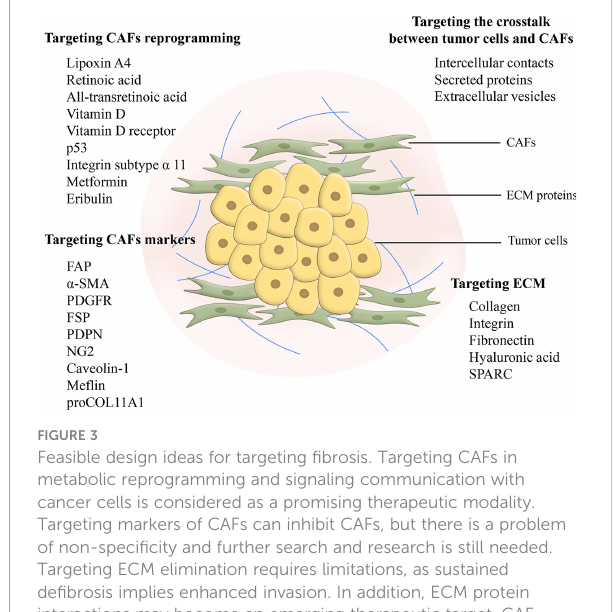
FIGURE 3 Feasible design ideas for targeting fi brosis. Targeting CAFs in metabolic reprogramming and signaling communication with cancer cells is considered as a promising therapeutic modality. Targeting markers of CAFs can inhibit CAFs, but there is a problem of non-speci fi city and further search and research is still needed. Targeting ECM elimination requires limitations, as sustained de fi brosis implies enhanced invasion. In addition, ECM